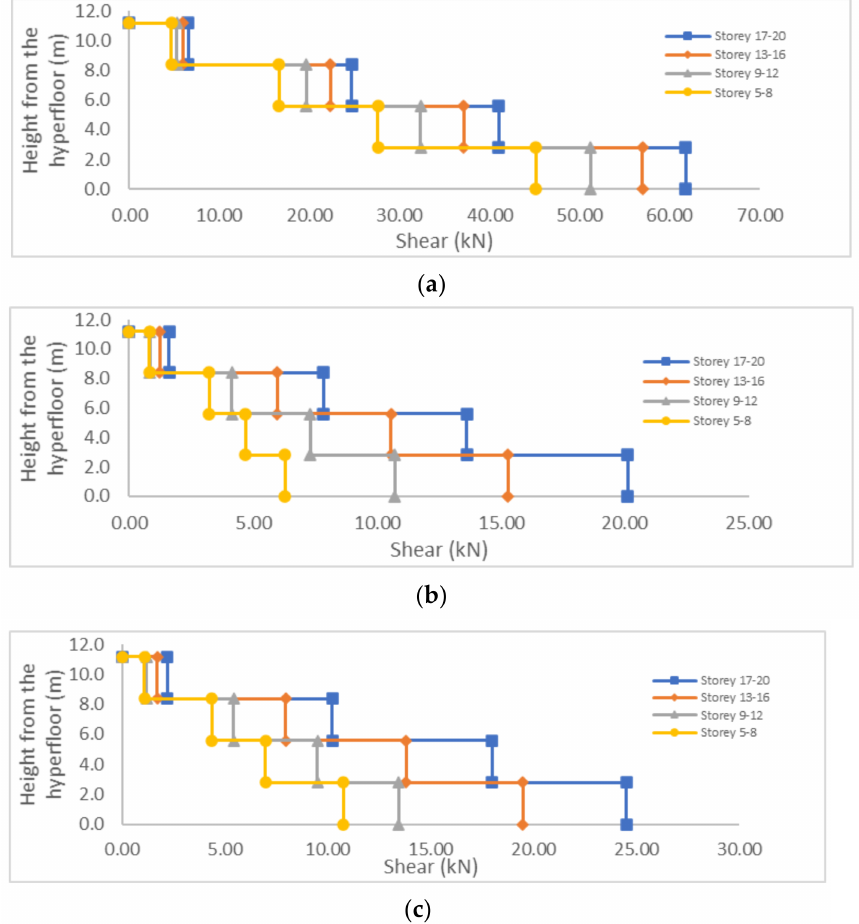
Figure 11. Shear experienced by the shearwall segments of the long modules under factored seismic- load combination 1.0 E + 1.0 D + 0.5 L + 0.25 S. The end shearwall segments of 3.475 m in length are shown in ( a ), the segments of 3.0 m length are shown in ( b ) and the segments of 3.5 m length are shown in ( c ).